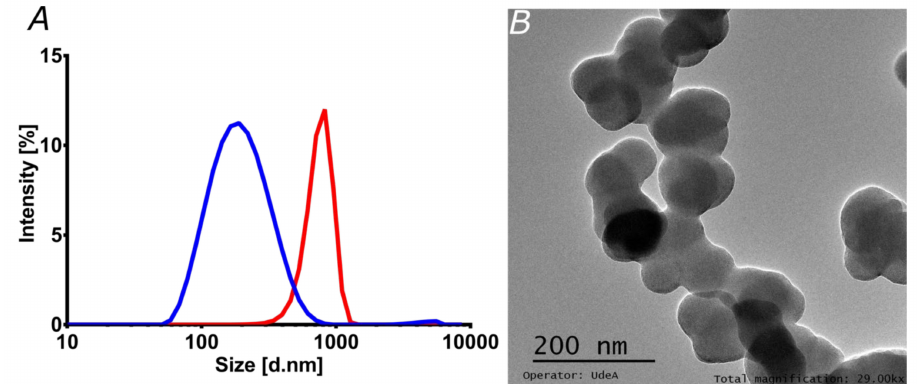
Figure 3. Characterization of liposomes and magnetoliposomes. ( A ) Liposomes (blue) and magnetoliposomes (red) size distribution by Dynamic Light Scattering. The size was estimated using the refractive index and absorbance parameters of the phospholipid membrane. ( B ) TEM image of the liposomes synthesized by the hydration of the lipid bilayer